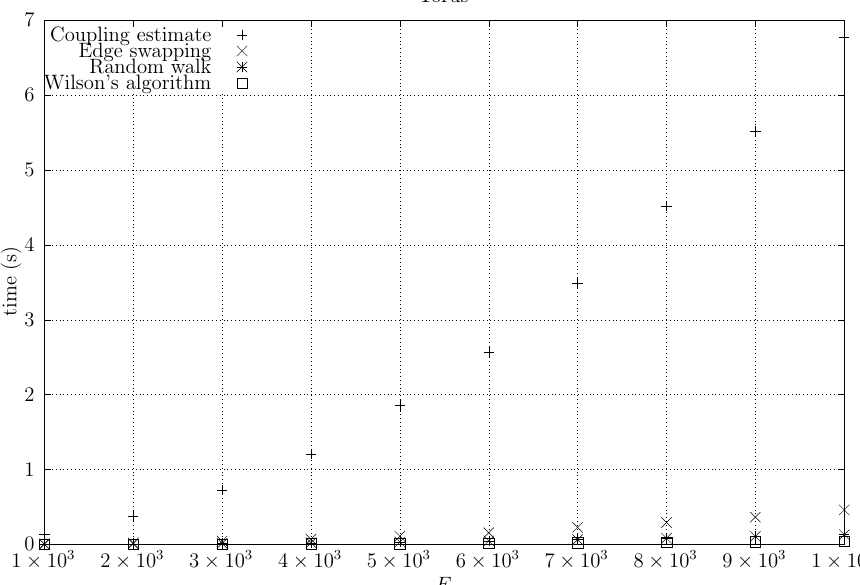
Figure 31. Running times for rectangular torus graphs averaged over five runs, including the running time for computing the optimistic coupling estimate, the running time for generating a spanning tree based on that estimate, the edge-swapping algorithm, the running time for generating a spanning tree through a random walk, and the running time for Wilson’s algorithm.